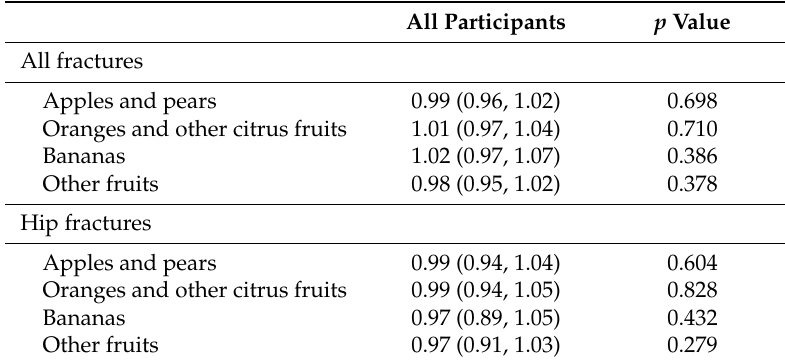
Table 6. Multivariable-adjusted hazard ratios for fracture-related hospitalisation by fruit